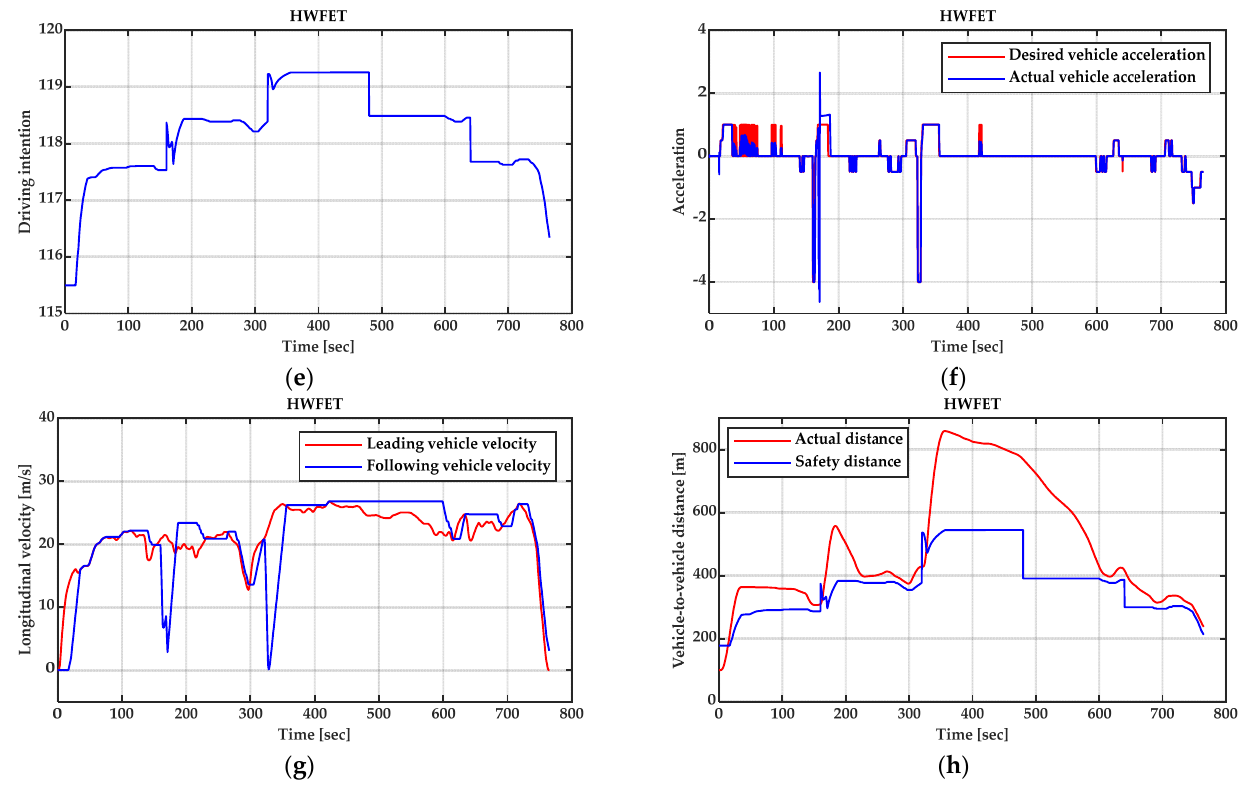
Figure 9. Dry asphalt–snow–ice-mixed road experiments in HWFET with deep neural network. ( a ) Road characteristic parameter of left and right tires. ( b ) Average adhesion coefficient. ( c ) Adhesion coefficients of front tires. ( d ) Adhesion coefficients of rear tires. ( e ) Driving intention. ( f ) Acceleration of following vehicle. ( g ) Longitudinal velocities of leading and following vehicles. ( h ) Vehicle-to-vehicle distance and actual distance.